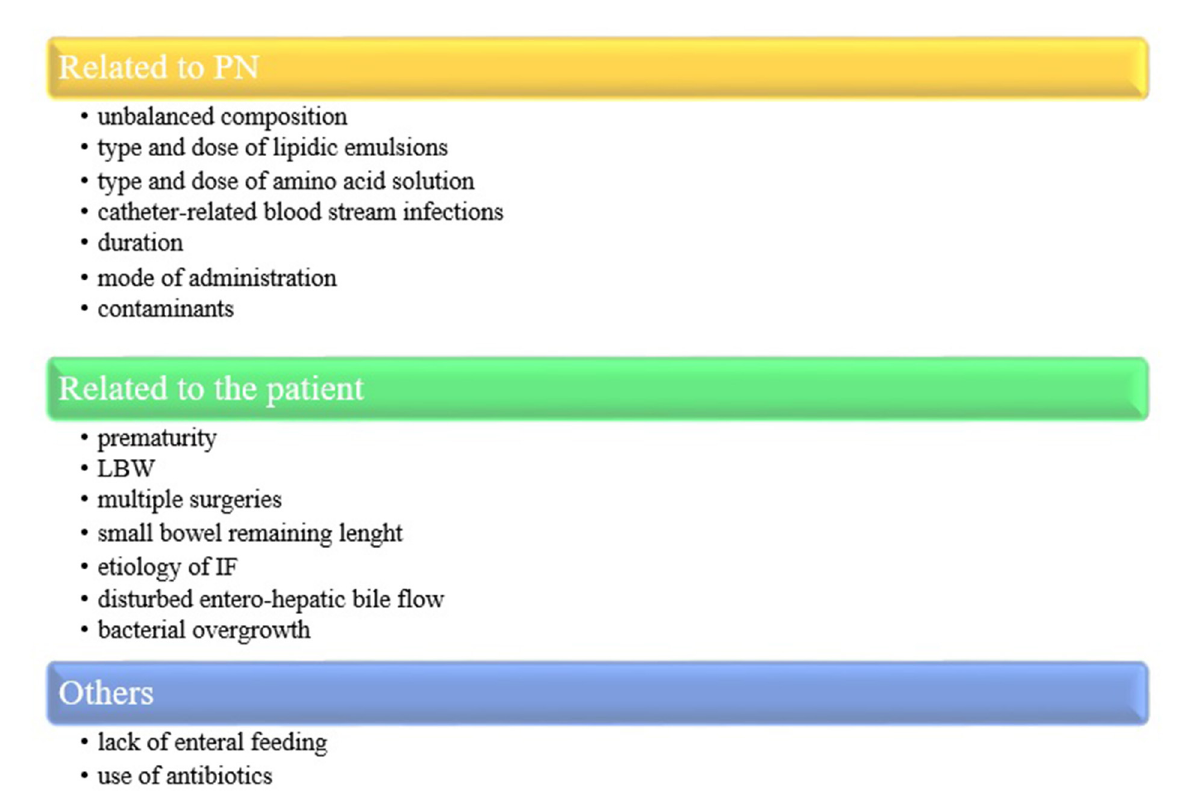
FIGURE1 Risk factors for IFALD. PN, parenteral nutrition; LBW, low birth weight; IF, intestinal